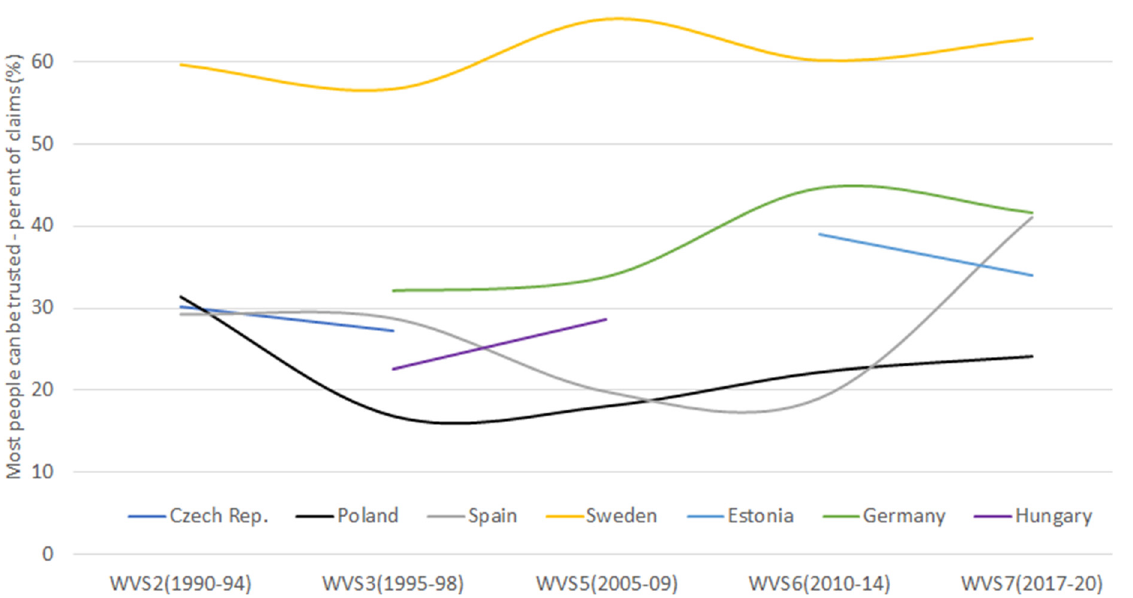
Figure 17. Level of trust in other people (1990–2020). Most people can be trusted (percent of claims). Source: WVS, waves 2–7